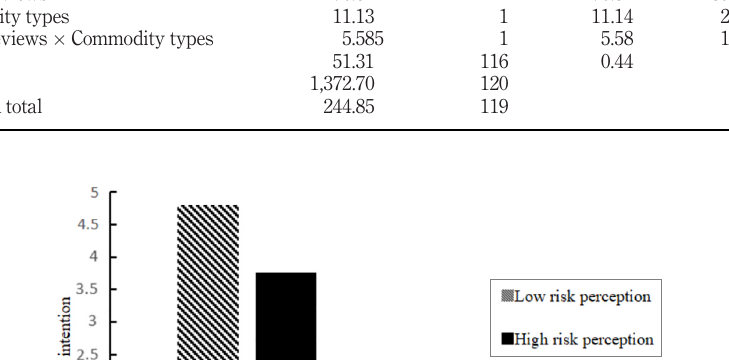
Figure 2. The interaction among of online reviews and risk perception on consumer purchase intention